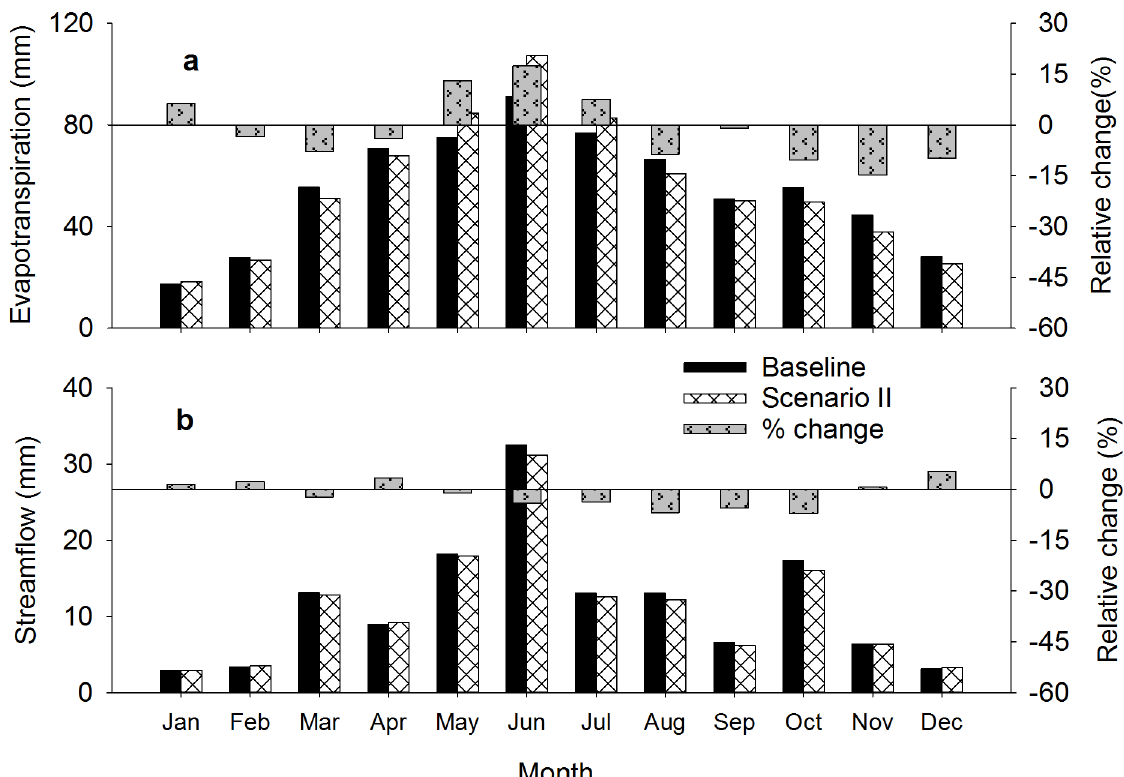
Fig 6. Simulated averagemonthly evapotranspiration(a) and streamflow (b) for 2002–2011for the baselineand scenario-II (marginalcroplandconversion to switchgrass).